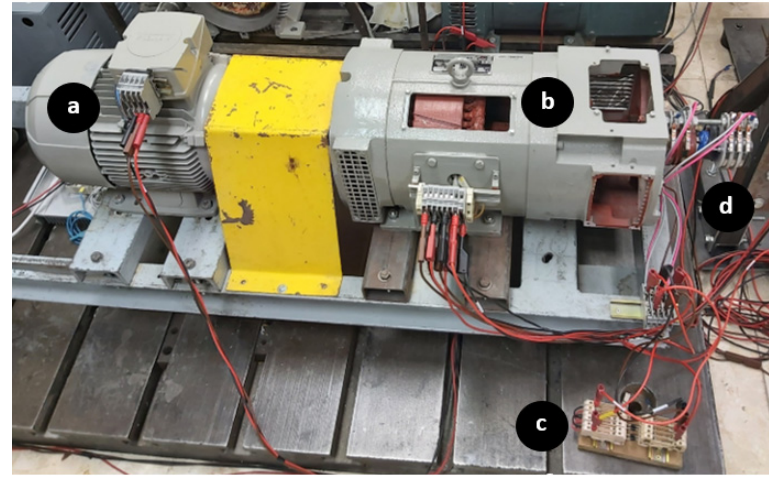
Figure 9. Experimental test bench (( a ) asynchronous motor; ( b ) BSM; ( c ) diode rectifier; ( d ) brushes and slip rings). Table 2. Main machine data.